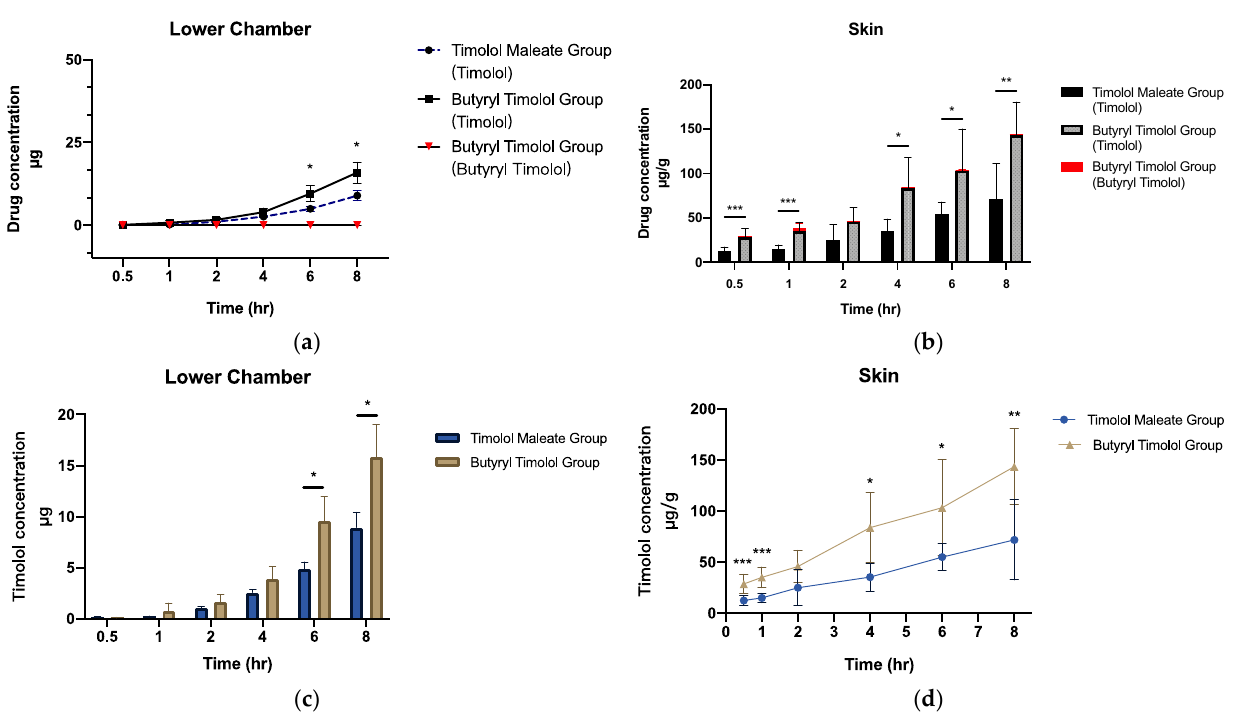
Figure 3. Ex vivo skin permeation and skin retention data of TM and BT application across porcine skin ( a ) cumulative flux (µg) and ( b ) skin retention (µg/g) of timolol and butyryl timolol after TM and BT application across time. ( c ) Cumulative flux (µg) and ( d ) skin retention (µg/g) of timolol alone after topical BT and TM application across time. All data are presented as the mean ± SD (n = 6). * p < 0.05; ** p < 0.01; *** p < 0.005.